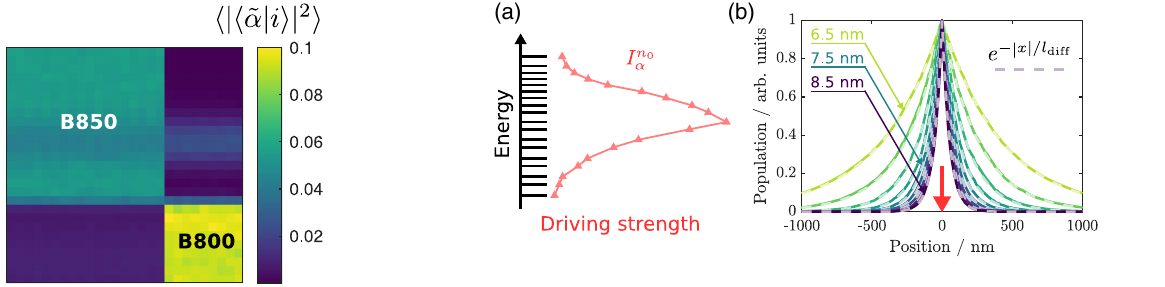
FIG. 8. Driving profile and excitonic stationary spatial distri- bution. (a) Driving at the central ring takes place in the B800 pigments, with a distribution across the excitonic spectrum given by Eq. (F1). The profile is averaged over 10 4 realizations of static disorder. (b) Injection at a single site (at x ¼ 0 ) results in an exponential exciton distribution along the light-harvesting array. Results are shown for intercomplex distances ranging from 6.5 nm to 8.5 nm. The exciton distributions obtained numerically (solid lines) fully agree with exponential distributions of different diffusion length (dashed lines). Numerical results are obtained as averages over 10 3 realizations of static disorder.